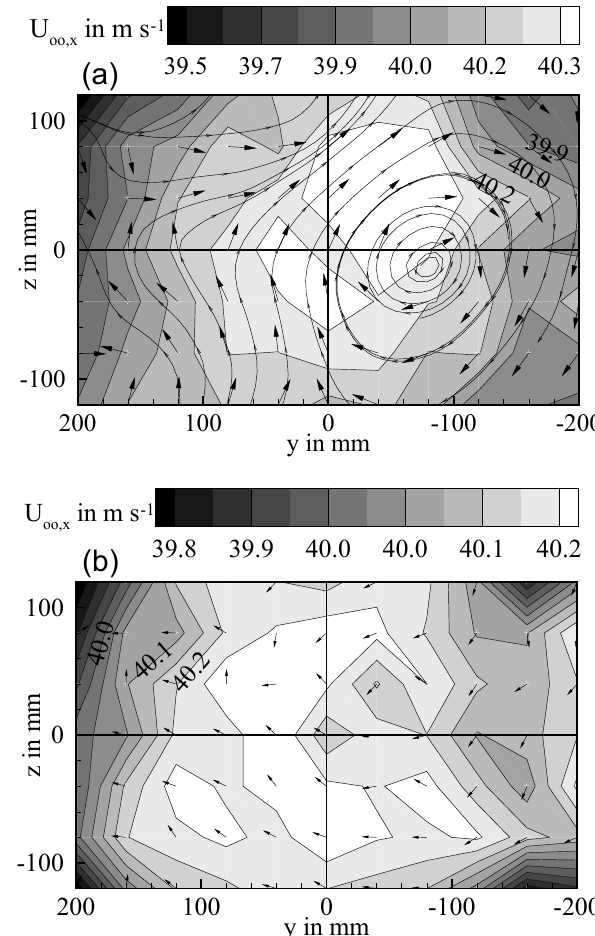
Figure 19. Spatial distribution of axial flow velocity U ∞ , x , (a) ice- crystal-icing setup and (b) standard setup of the icing wind